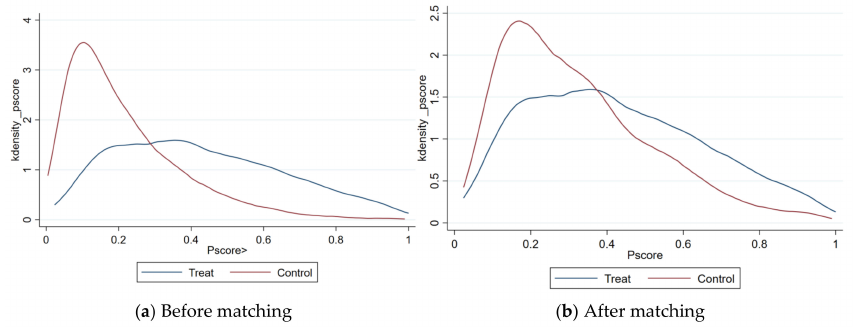
Figure 2. Kernel density before and after matching.